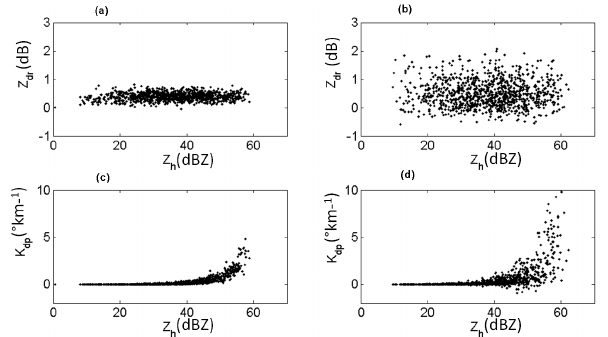
Figure 1. Scatter plots of C-band differential reflectivity (a, b) and specific differential phase shift (c, d) vs. reflectivity factor obtained by T -matrix simulations for graupel. Left panels refer to spheroid graupel simulations (details in second column of Table 1), while right panels refer to conical graupel simulations (third column of Table